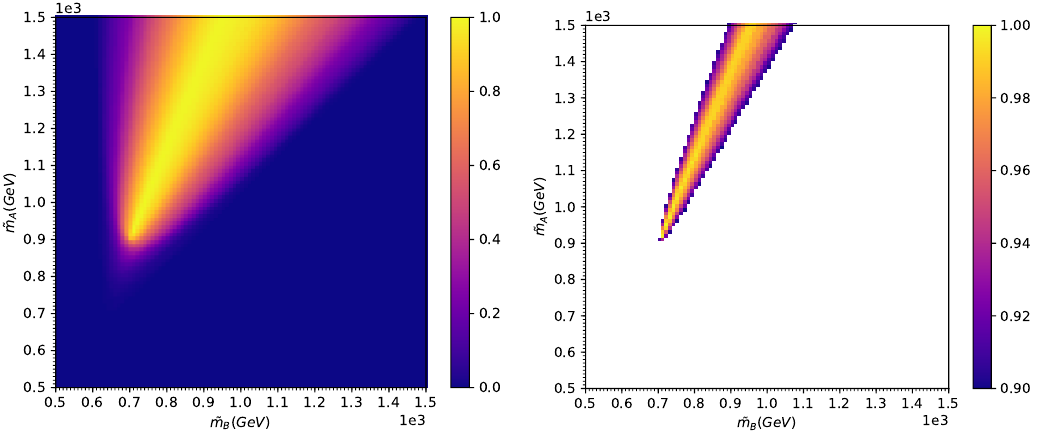
Figure 9 . Solvability heat maps as in (cid:12)gure 7, except here ~ m